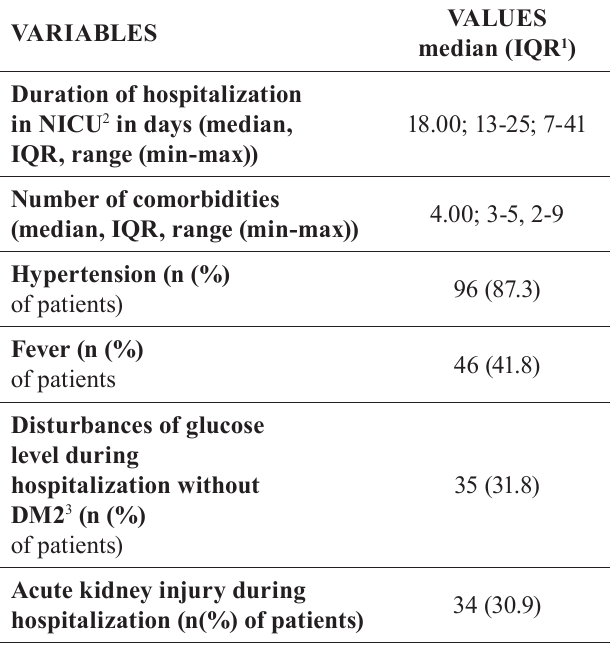
TABLE I - C linical characteristics of patients with sICH VARIABLES